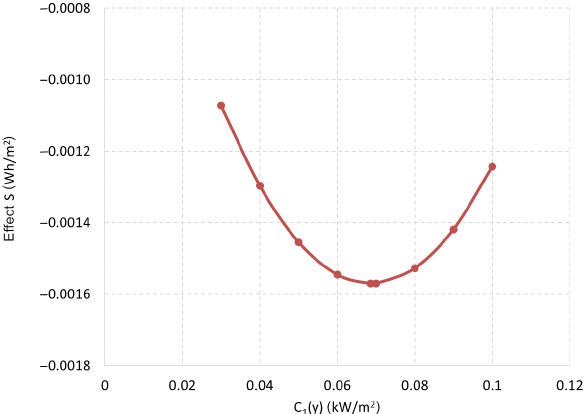
Figure 8. Demonstration of the minimum energy effect values. Distribution of the effect depending on C 1 position.